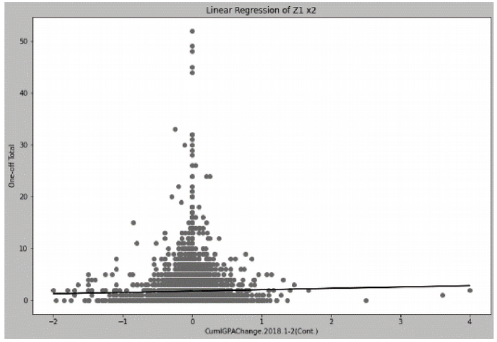
Figure 2. Linear Regression of Z1 x2 in Finding 1